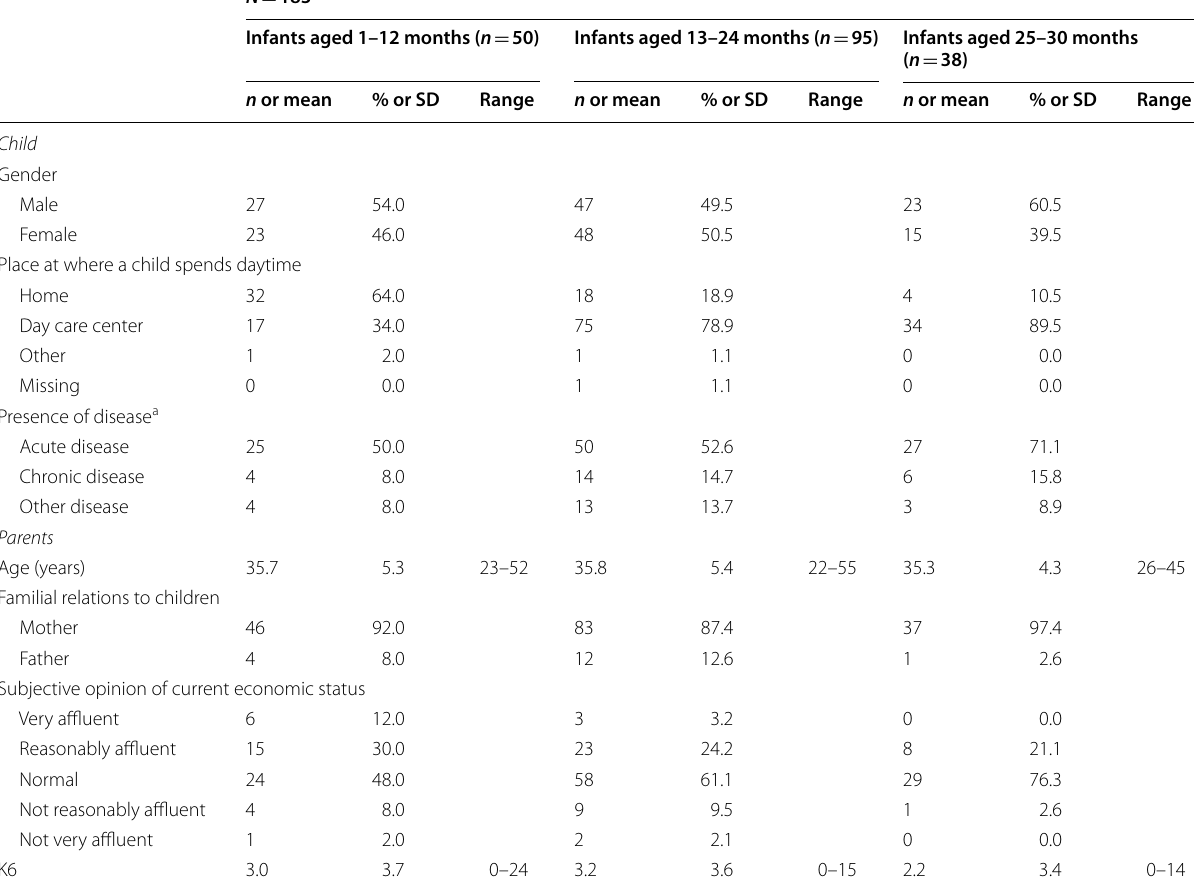
Table 1 Socio-demographic